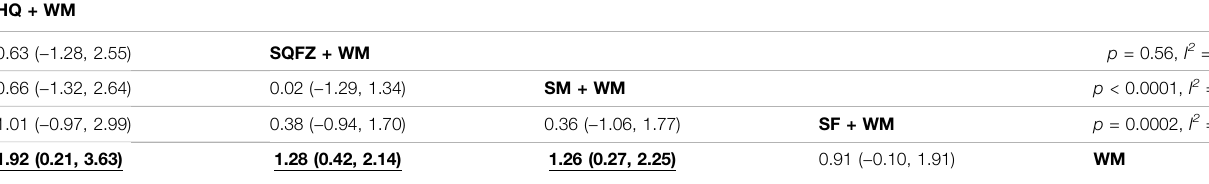
TABLE 8 | SMDs with 95% CIs of CD4 + . Signi fi cant effects are printed in